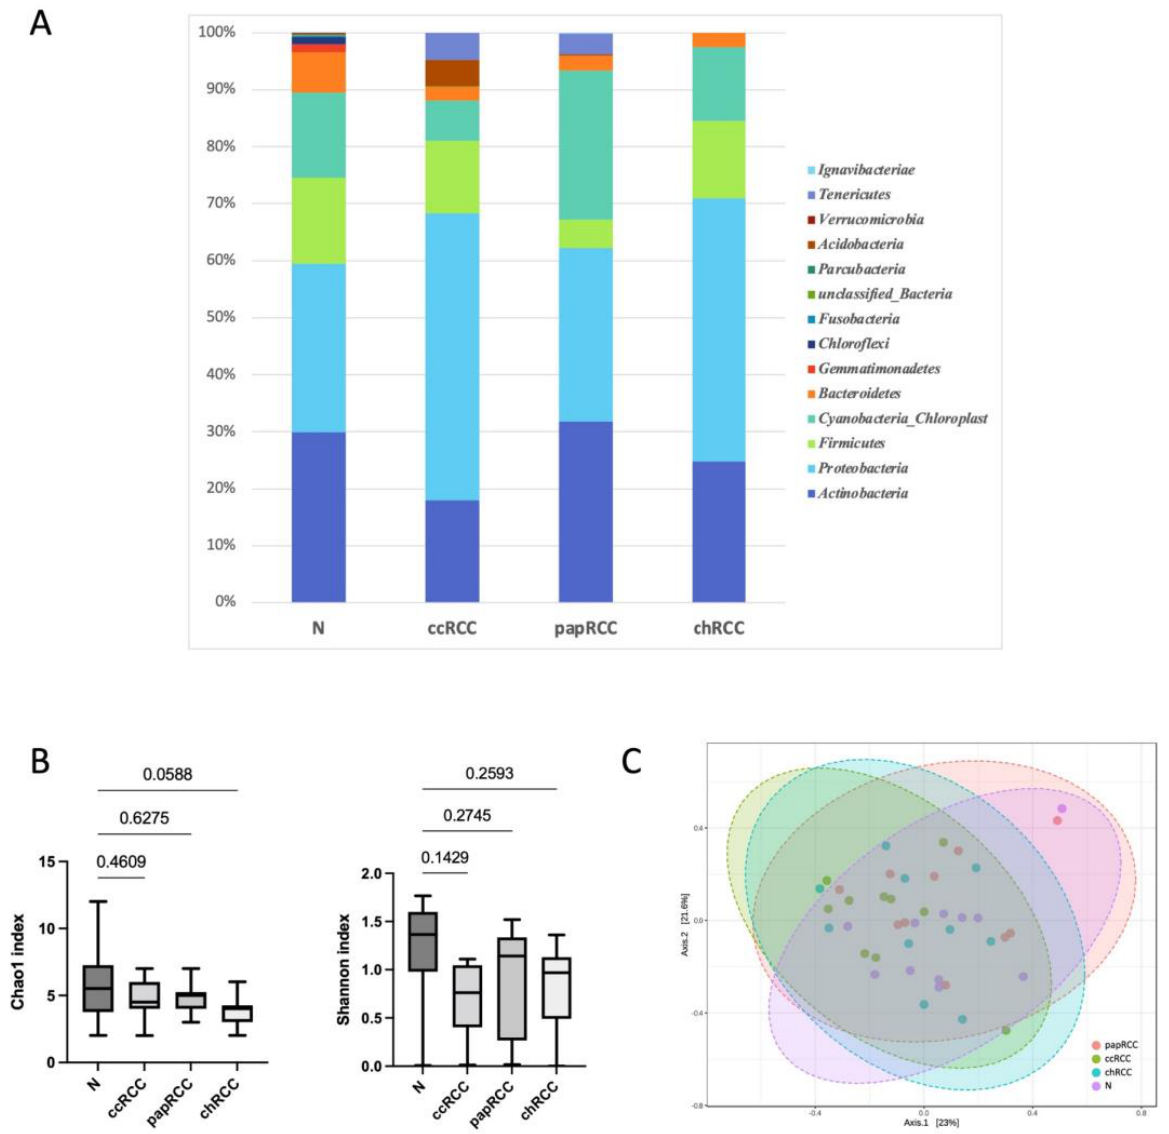
Figure 1. Taxonomic composition of the microbial community of renal tissues on the level of phylum. ( A ) Characterization of renal cell cancer (RCC) microbiota. Colored lines represent relative abundance at the phylum level for tumor (ccRCC, papRCC, chRCC) and normal tissue (N) samples. ( B ) Taxonomic α -diversity calculated with Shannon and Chao1 indices between N and T groups; p -values are indicated above the lines. ( C ) PCoA plot based on Bray – Curtis distance of renal microbiome between tumor and normal tissues (PERMANOVA). F-value: 0.97931; R- squared: 0.073562; p -value < 0.462.